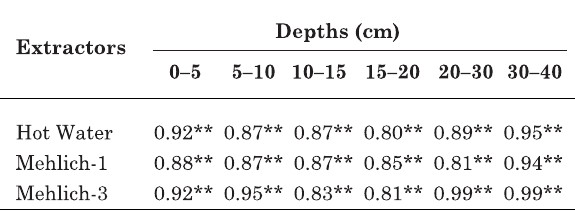
** in the columns, significant correlation at 1.0 %